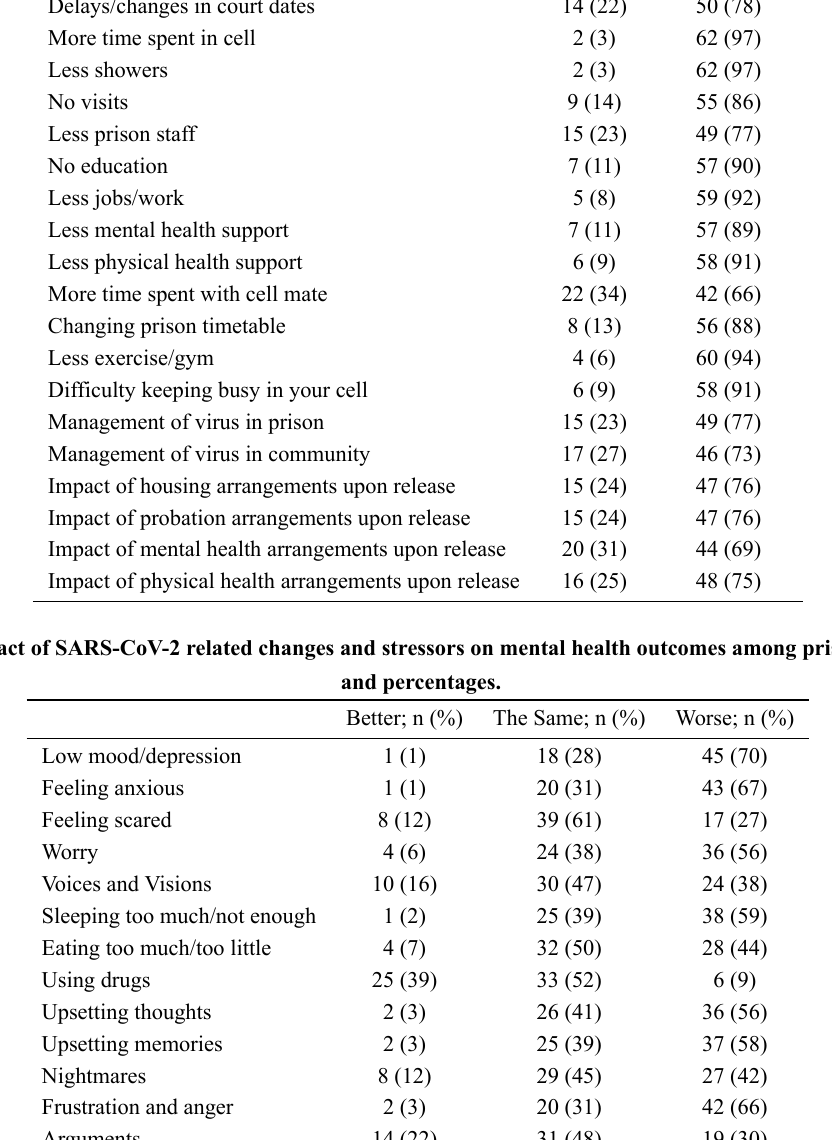
Found it hard or worrying.